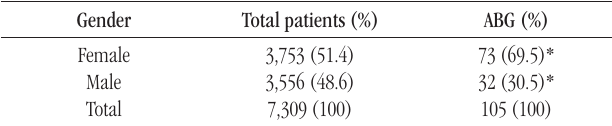
taBLE 1 − Gender distribution of total patients who underwent esophagogastric endoscopy with biopsy and patients with the final diagnosis of ABG Gender